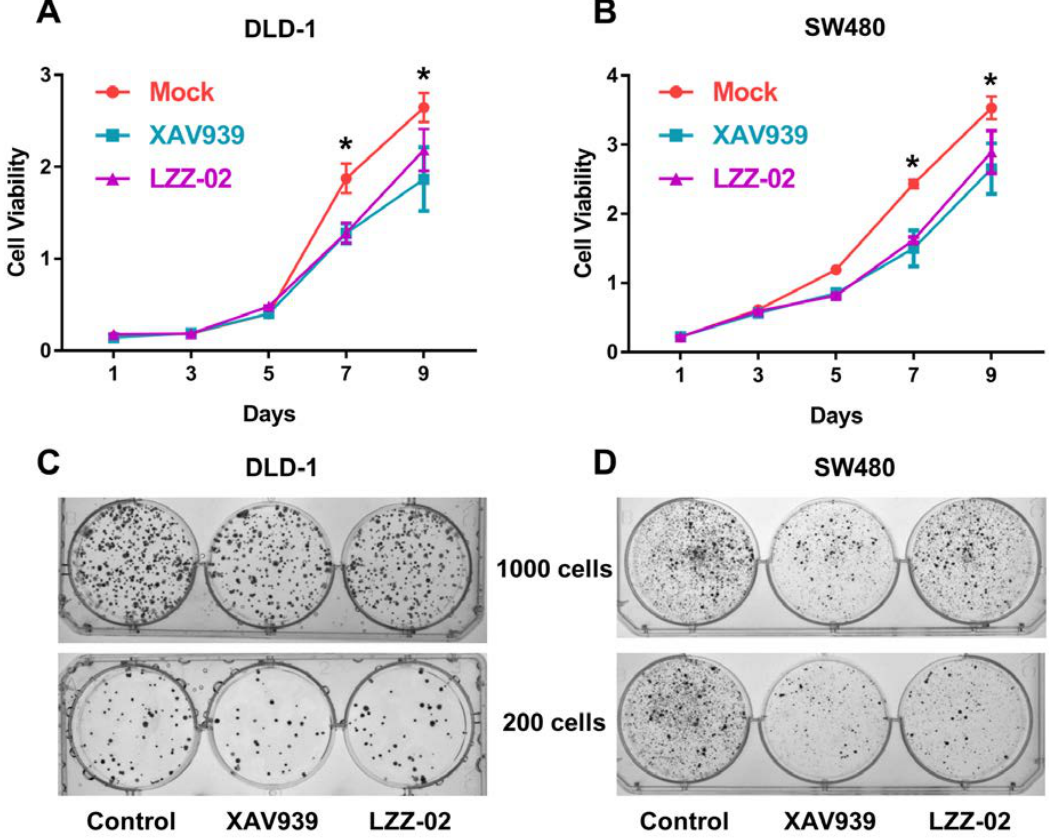
Figure 5. LZZ-02 and XAV939 inhibits cell proliferation of human colorectal cancer cells. ( A , B ): human colorectal cancer cell viability was significantly reduced upon LZZ-02 or XAV939 compound treatment. DLD-1 ( A ) and SW480 ( B ) cell line (500 cells) were treated without or with WNT inhibitors (30 µ M), and ell viability was detected by a CCK-8 assay kit for the indicated time points. ( C , D ): LZZ-02 or XAV939 inhibits colony forming of human colorectal cancer cells. DLD-1 ( C ) and SW480 ( D ) cell line (200–1000 cells) were treated without or with WNT inhibitors (30 µ M) for two weeks, and the cells were stained with 0.5% crystal violet. Representative images of the colony-forming assay of DLD1 and SW480 cells. Data are presented as mean (n = 3) ± SD. * p < 0.05.